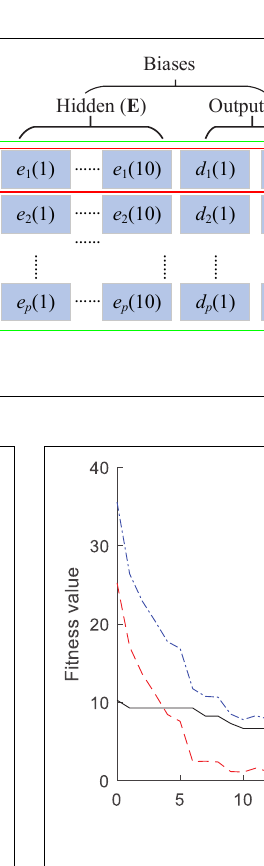
FIGURE 7 | The iteration of SGA of a convergent case (Note f a − f min decreases).